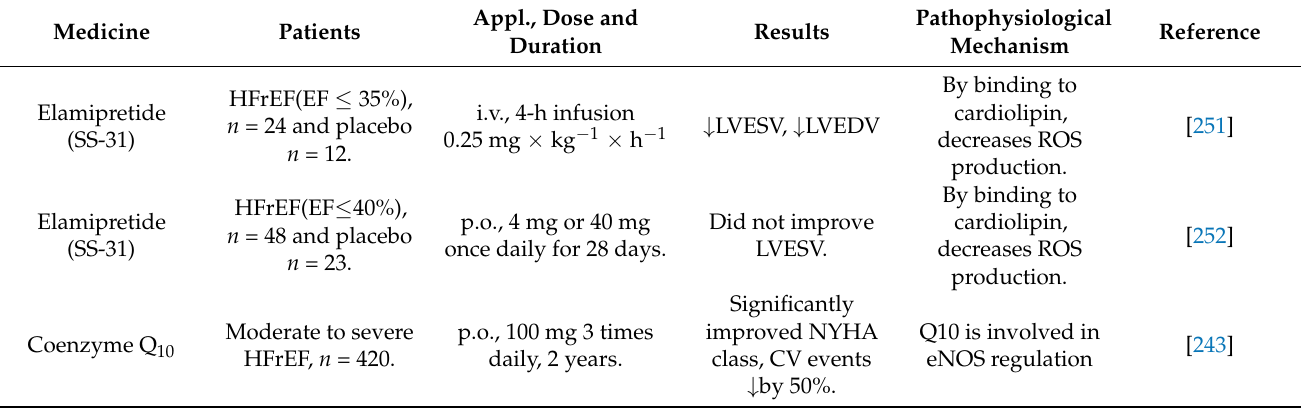
Table 3. Medicines affecting human cardiomyocyte mitochondria in chronic HF patients.